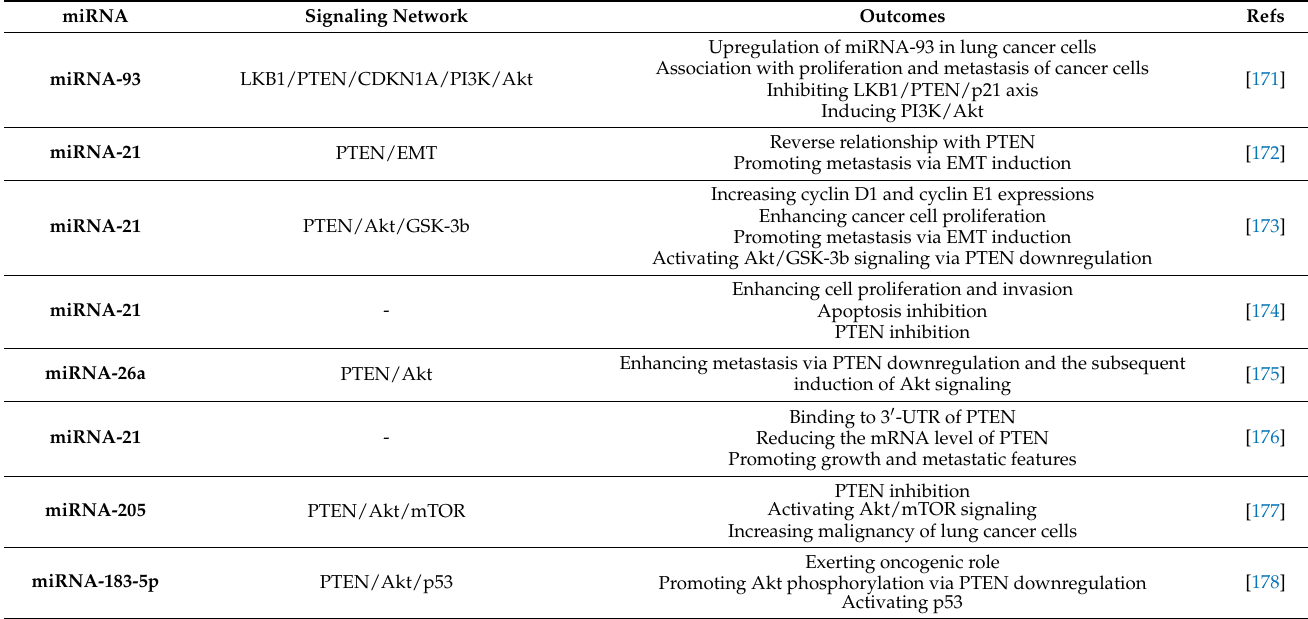
Table 2. miRNAs inhibiting PTEN expression in enhancing lung cancer